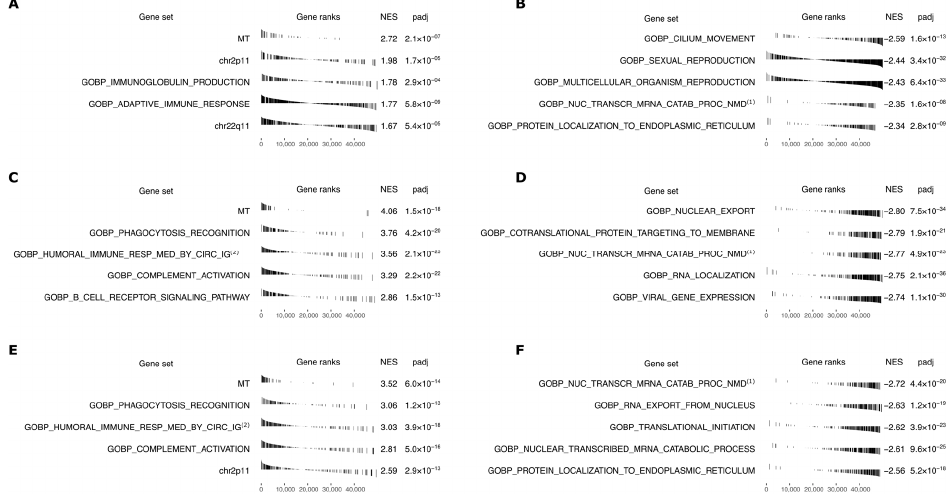
Figure 2. GSEA results for correlations of gene expression sex bias with IRSB across 10 GTEx tissues (adrenal gland, brain, colon, kidney, liver, pancreas, skin, small intestine, stomach, and thyroid). Top 5 positively and negatively enriched gene sets, with adjusted p ≤ 10 − 3 , for AID incidence (positive, ( A ); negative, ( B )), cancer incidence (positive, ( C ); negative, ( D ), and AIDs and cancers jointly (positive, ( E ); negative, ( F )). For each gene set the plot shows: (Gene set) name; (Gene ranks) bar plot of corr ESB/IRSB values ordered from highest correlation at the left to lowest at the right (bars for genes in the gene set are black); (NES) normalized enrichment score; and (padj) Benjamini-Hochberg corrected p -value. Abbreviated gene set names: (1) Gene Ontology Biological Process (GOBP) Nuclear transcribed mRNA catabolic process nonsense-mediated decay; (2) GOBP Humoral immune response mediated by circulating immunoglobulin; (3) GOBP Nuclear transcribed mRNA catabolic process.